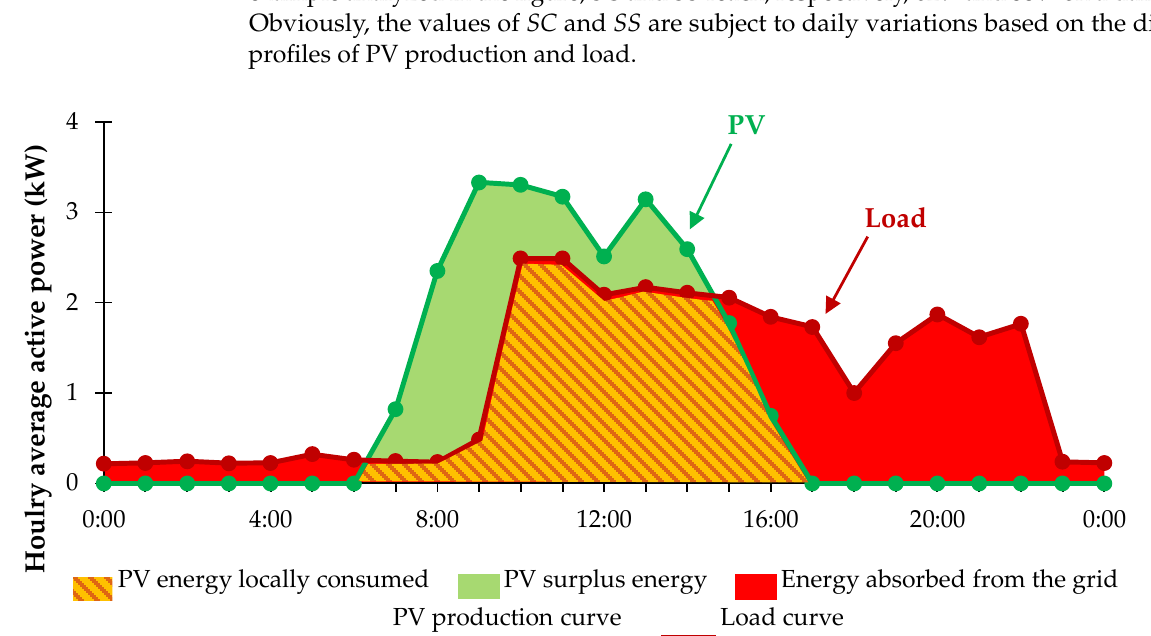
Figure 1. Generic example of PV generation and load profiles of a domestic user. Generally, production and consumption profiles rarely coincide: in this case, low val- ues of SS or SC are obtained due to this mismatch. In case of surplus (generation higher than consumption), the unused Renewable Energy Sources (RES) production may be in- jected into the electrical grid or wasted, resulting in low SC . On the contrary, deficit con- dition (generation lower than consumption) occurs, causing energy absorption from the grid and low SS . The maximization of the SC , along with the SS , determines benefits for the users and the electricity grid.